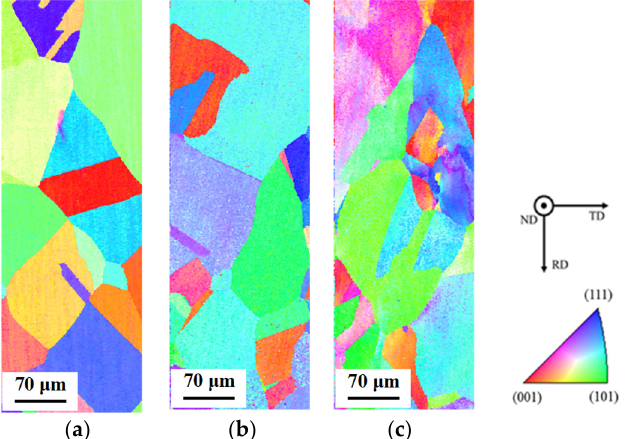
Figure 8. IPF maps of heat-treated C1020 specimens after low cycle fatigue test. ( a ) Stress amplitude: 50 MPa (fatigue cycle: 7,786,201 cycles); ( b ) stress amplitude: 75 MPa (fatigue cycle: 235,144 cycles); ( c ) stress amplitude: 100 MPa (fatigue cycle: 49,676